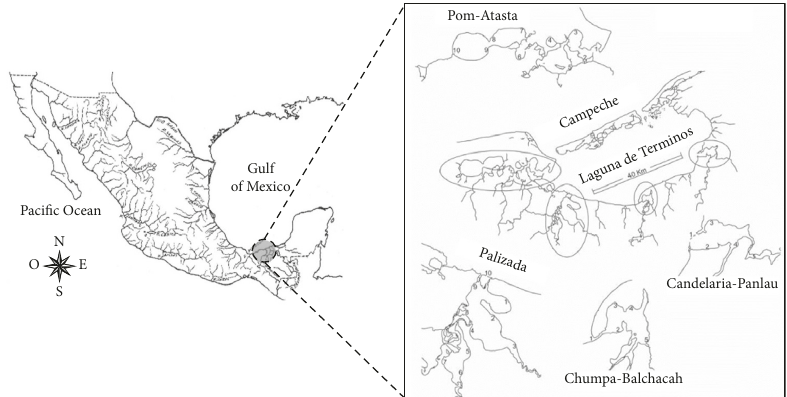
Figure 1: Main estuarine headwaters of Laguna de Terminos, Campeche, including the geographic region of the fish capture [38].